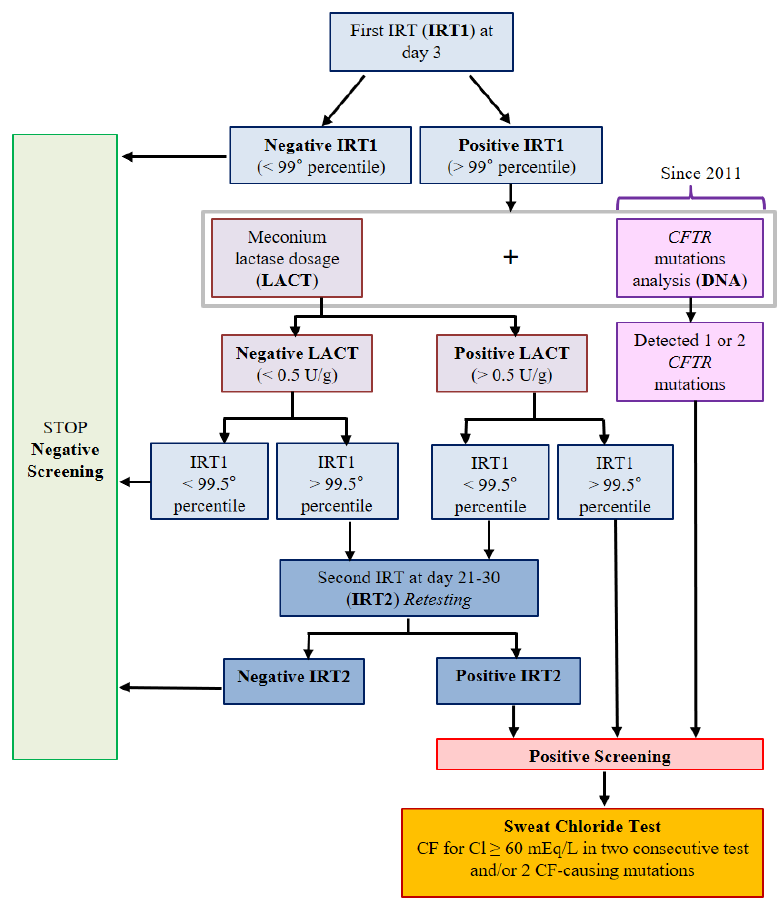
Figure 1. Cystic fibrosis newborn screening (CF NBS) algorithm adopted in Tuscany from 1992. The CFTR mutations analysis (on the right side of the graphs) was introduced in 2011.